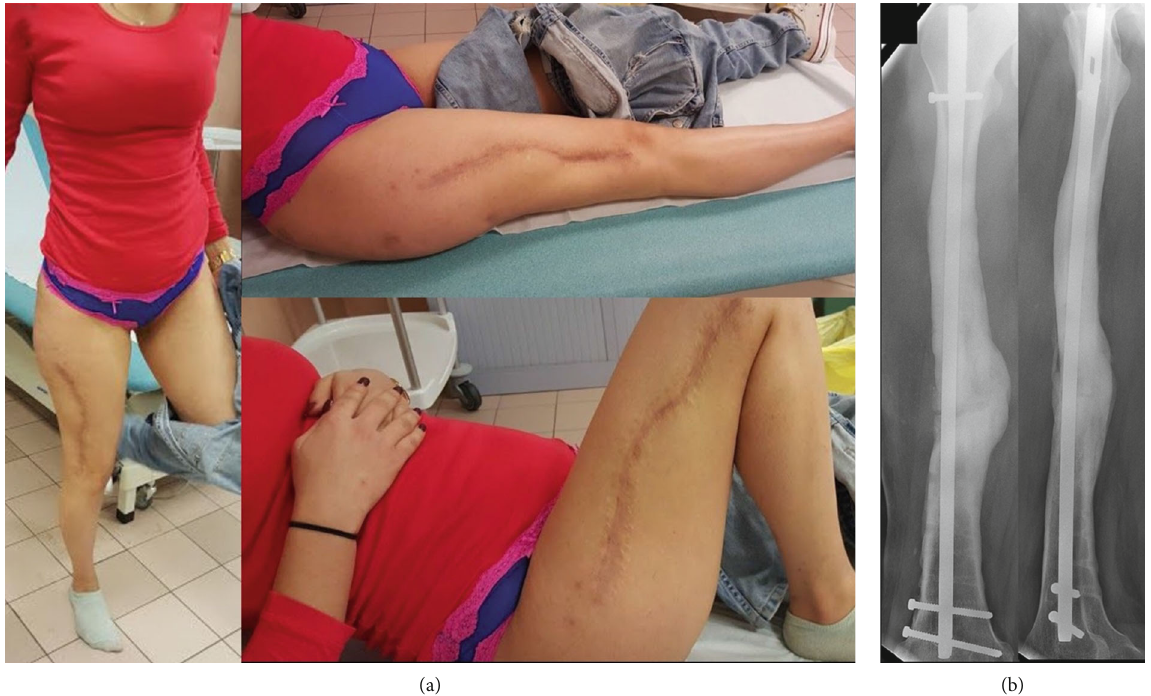
Figure 6: Final clinical (a) and radiological result at 32 weeks of follow-up from the atraumatic fracture